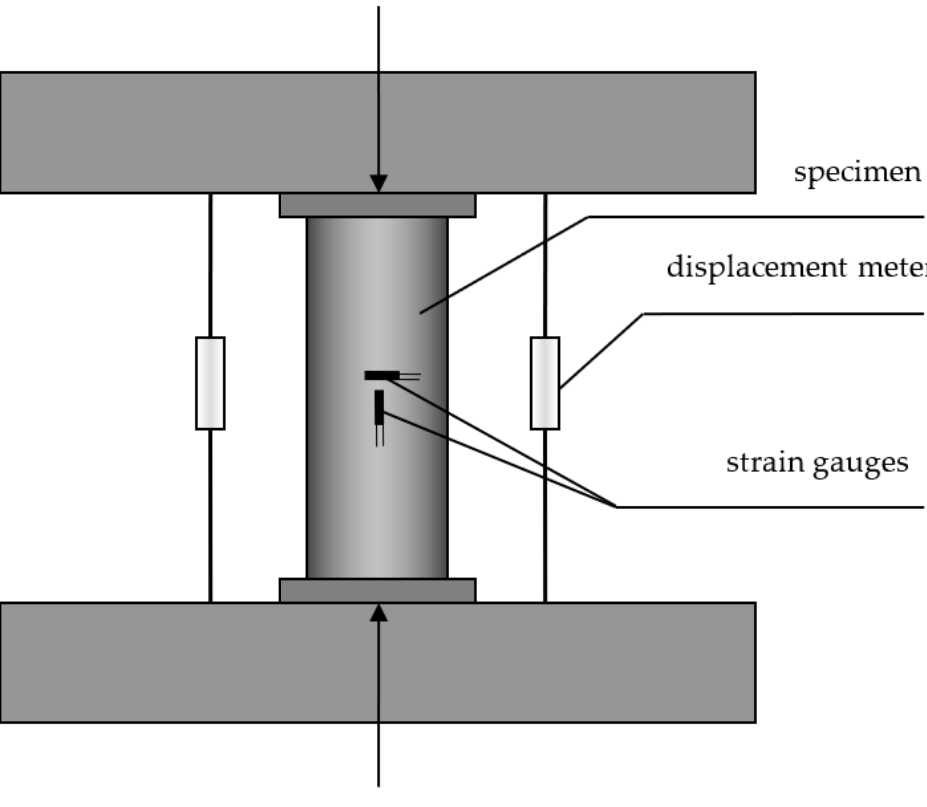
Figure 2. The test schematic diagram of CFST specimen.